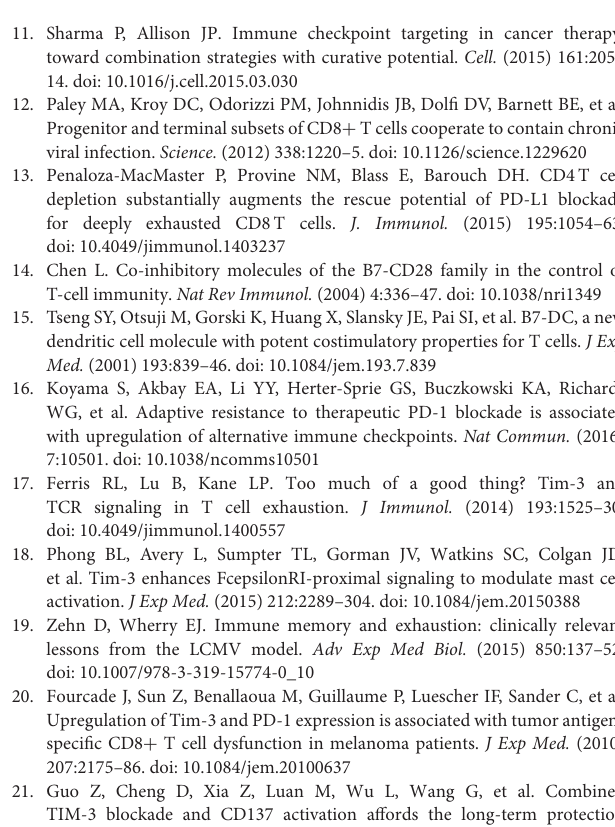
Supplementary Figure 1 | Mean fluorescence intensity (MFI) of PD-1, expression on (a) CD4 + and (b) CD8 + T cells in individual non-responders to Pembrolizumab. Supplementary Figure 2 | Mean fluorescence intensity (MFI) of TIM3, expression on (a) CD4 + and (b) CD8 + T cells in individual non-responders to